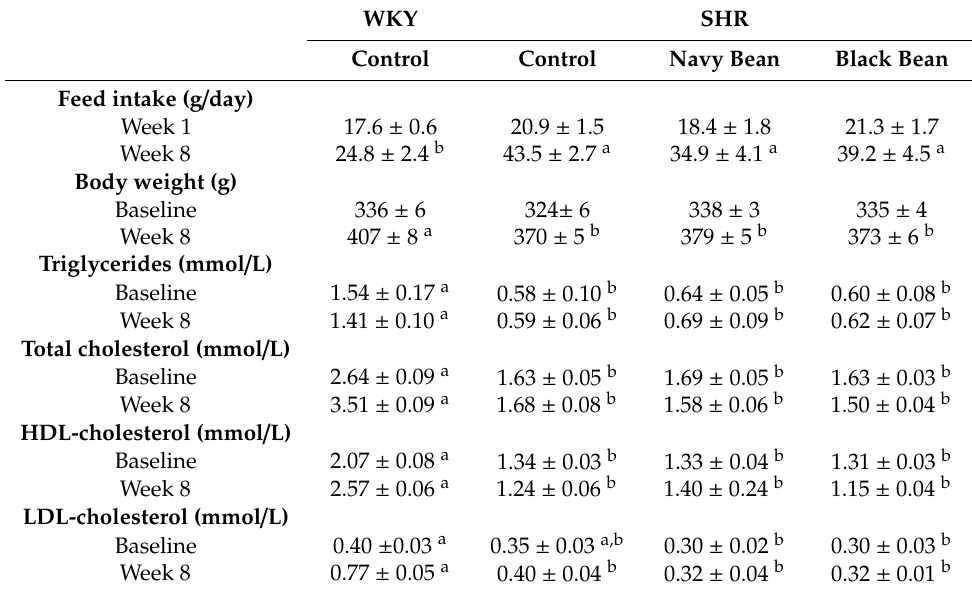
Table 2. Phase 1: Metabolic